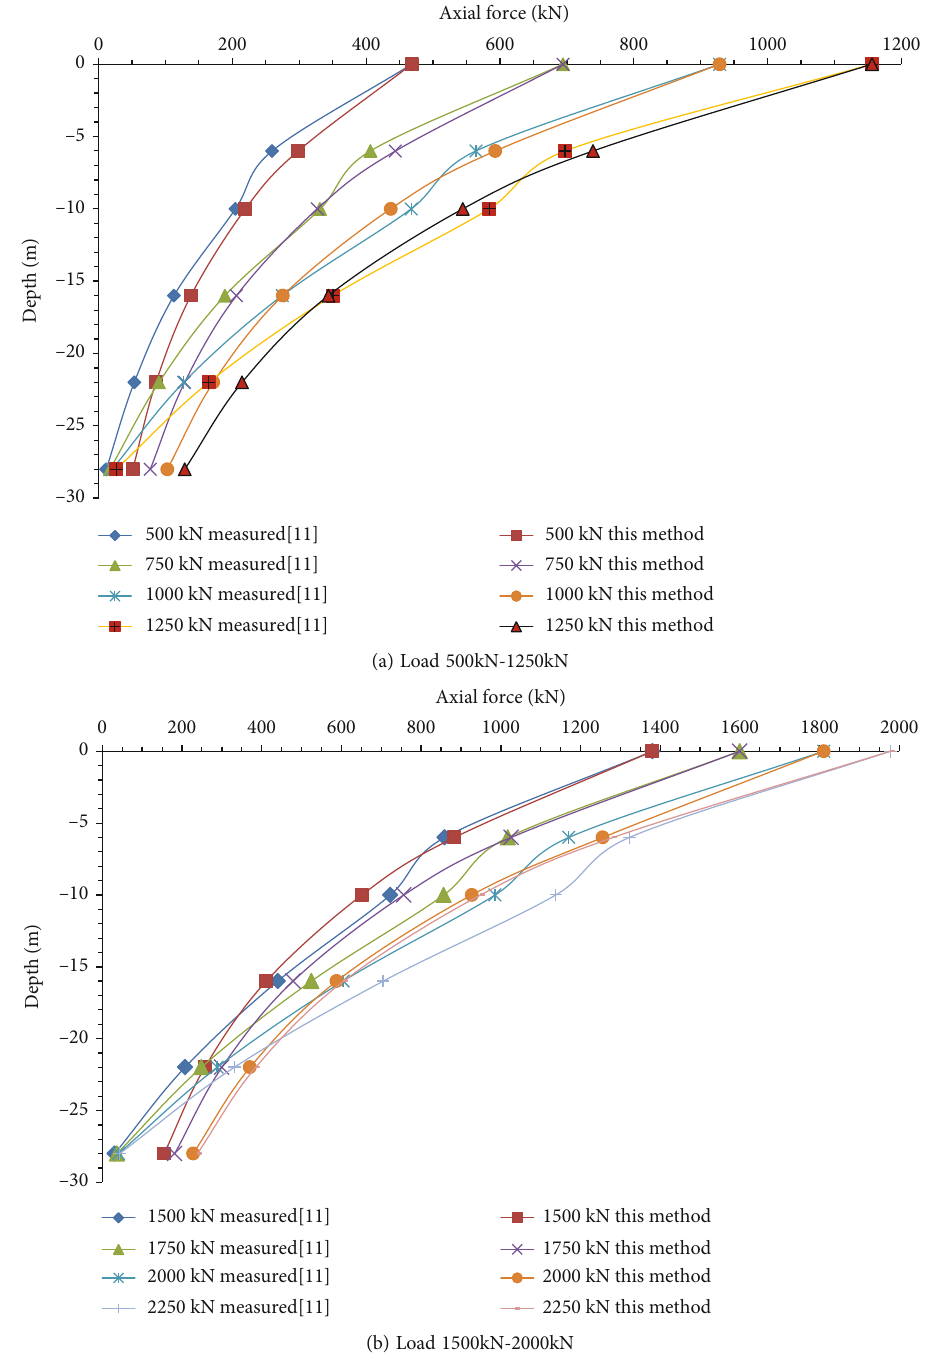
Figure 7: Axial force curves of T4 along pile